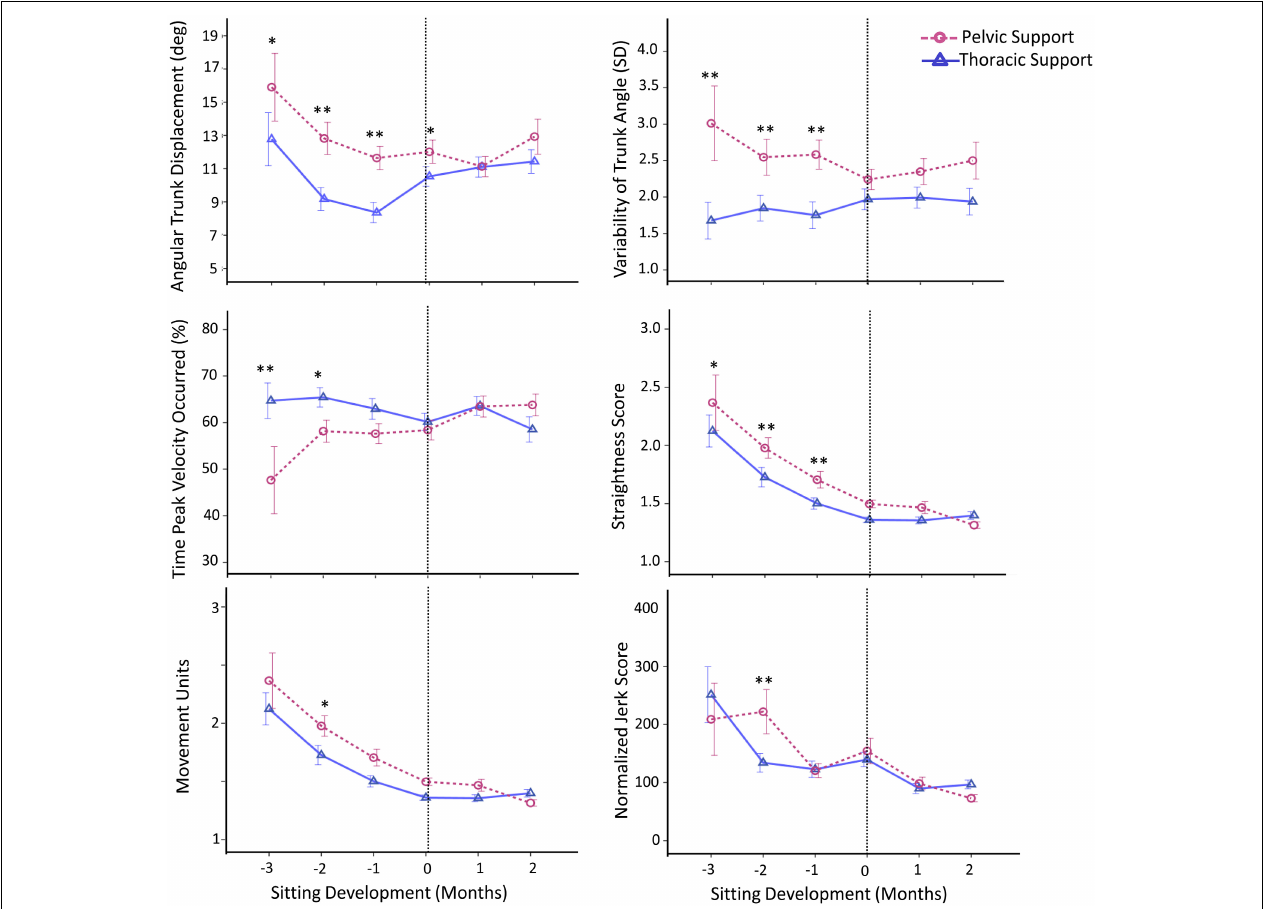
FIGURE 4 | Estimated means of group data across sitting developmental time. Y-axes display kinematic variables, X-axes display developmental time in months for thoracic (solid line with